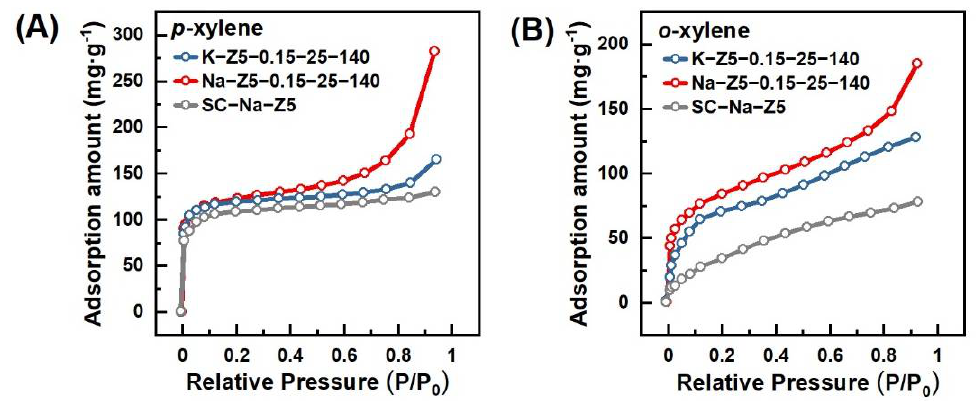
Figure 7. ( A ) The p -xylene adsorption isotherms of different ZSM-5 mesocrystals by IGA at 298 K, ( B ) The o -xylene adsorption isotherms of different ZSM-5 mesocrystals by IGA at 298 K.